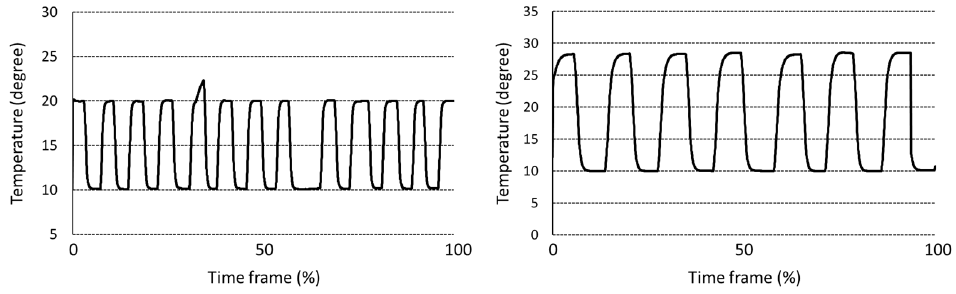
Figure 3. Dynamic temperature condition for measurement of egg freshness during storage.